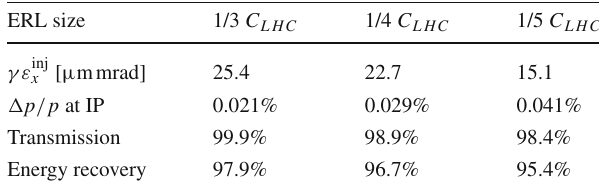
Fig. 21 Representation of the beta functions and the beam energy along the multi-turn ERL operation Table 6 Results of the tracking simulations including beam–beam effect and synchrotron radiation for different ERL